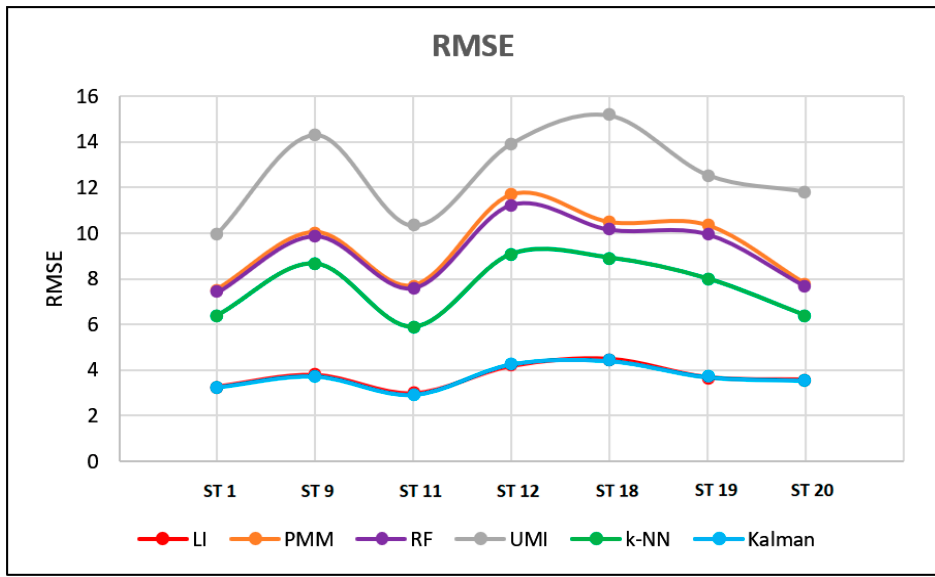
Figure 6. RMSE error for all models and stations.